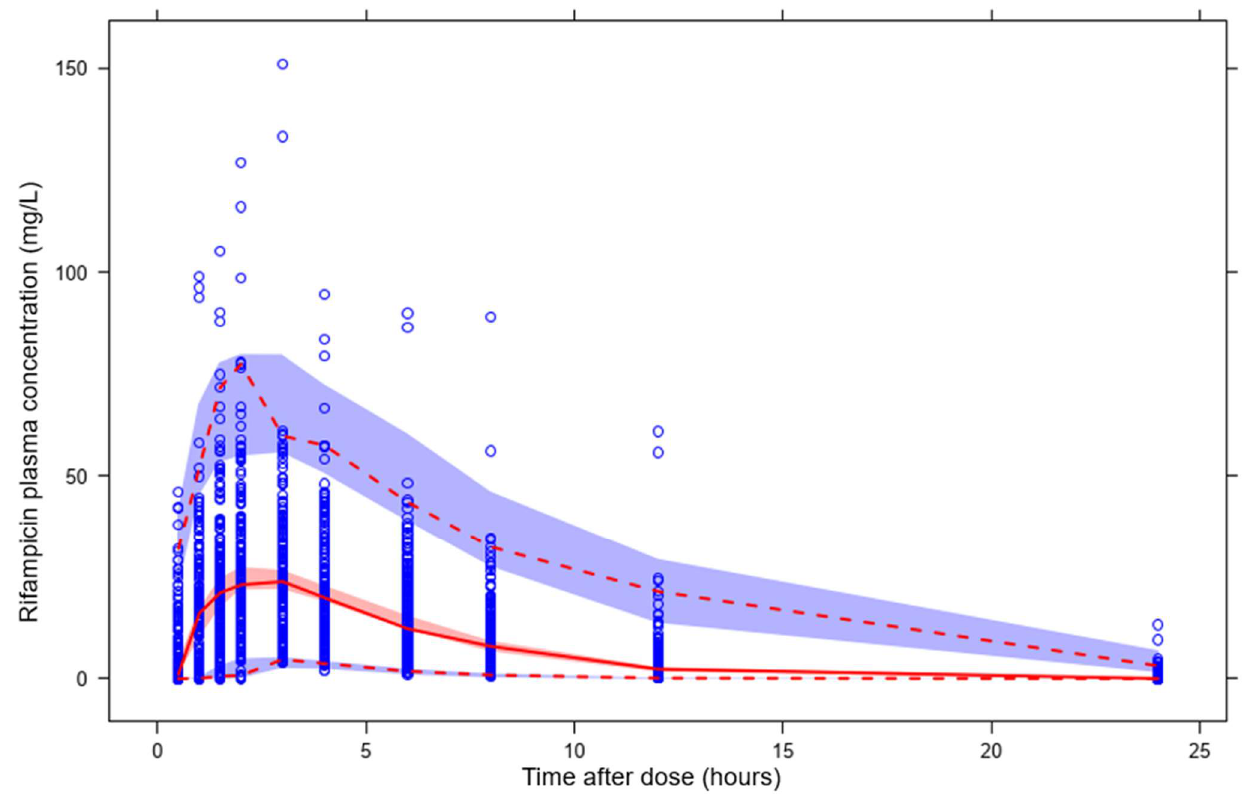
Figure 8. Visual predictive check for the re-estimated population PK model based on the simulated data. Open blue circles are the rifampicin plasma concentrations simulated from the population PK model, considered to be observed data in this study. The upper and lower dashed lines are the 95th and 5th percentiles of the observed data, respectively, and the solid line is the median of the observed data. The shaded areas (top to bottom) are the 95% confidence intervals of the 95th (blue shaded area), median (red shaded area) and 5th (blue shaded area) percentiles of the simulated data.